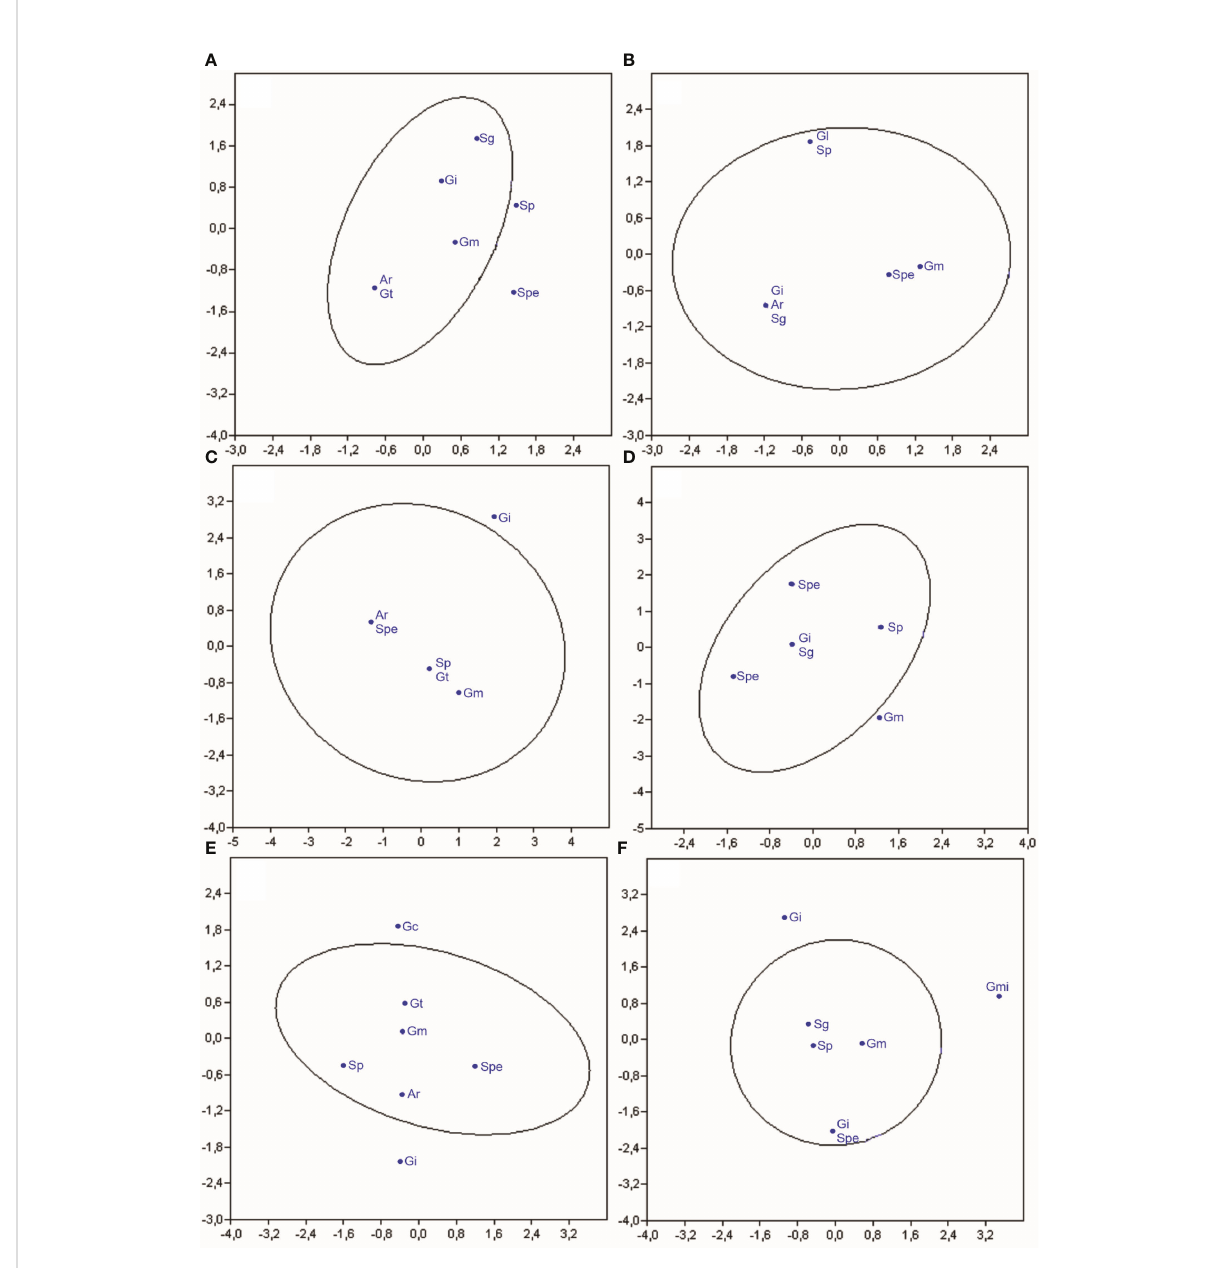
FIGURE 3 Canonical correspondence analysis of the frequency of arbuscular mycorrhizal fungal species in Crotalaria (A) , wild bean from Ceara ́ (B) , sorghum (C) , Guandu ́ (D) , millet (E) , and spontaneous vegetation (F) with and without nitrogen application. (Ar, Ar. leptoticha ; Gc, G. clarum ; Gm, G. macrocarpum ; Gmi, G. microaggregatum ; Gt, G. tortuosum ; Gi, Gigaspora sp ; Gl, Glomus sp.; Sg, S. gregaria ; Sp, S. pellucida ; Spe, S. persica